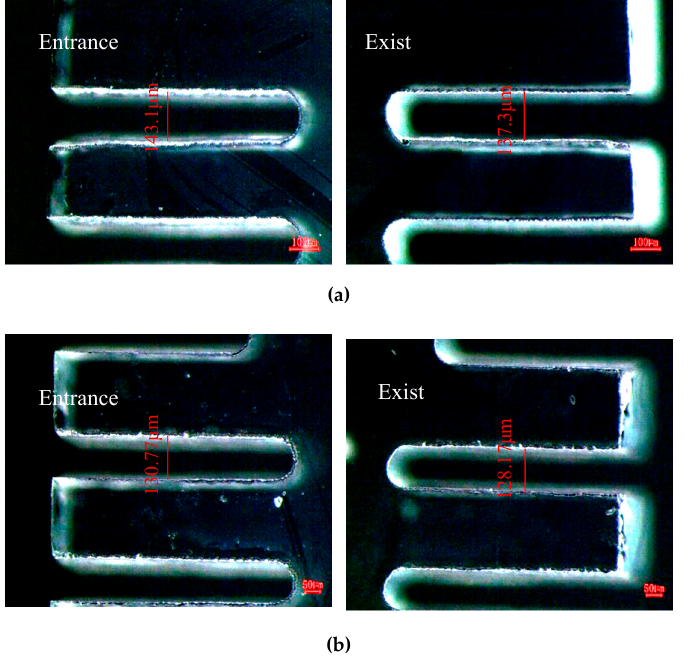
Figure 7. Comparison of slits with or without ultrasonic vibration. ( a ) Without ultrasonic vibration assistance. ( b ) With ultrasonic vibration assistance.